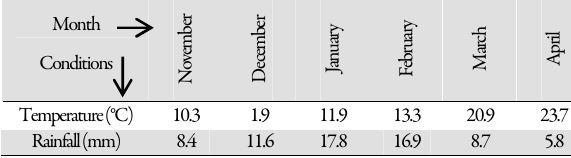
Tab. 2. Soil physical and chemical properties of the experimental site (0- 30 and 30-60 cm